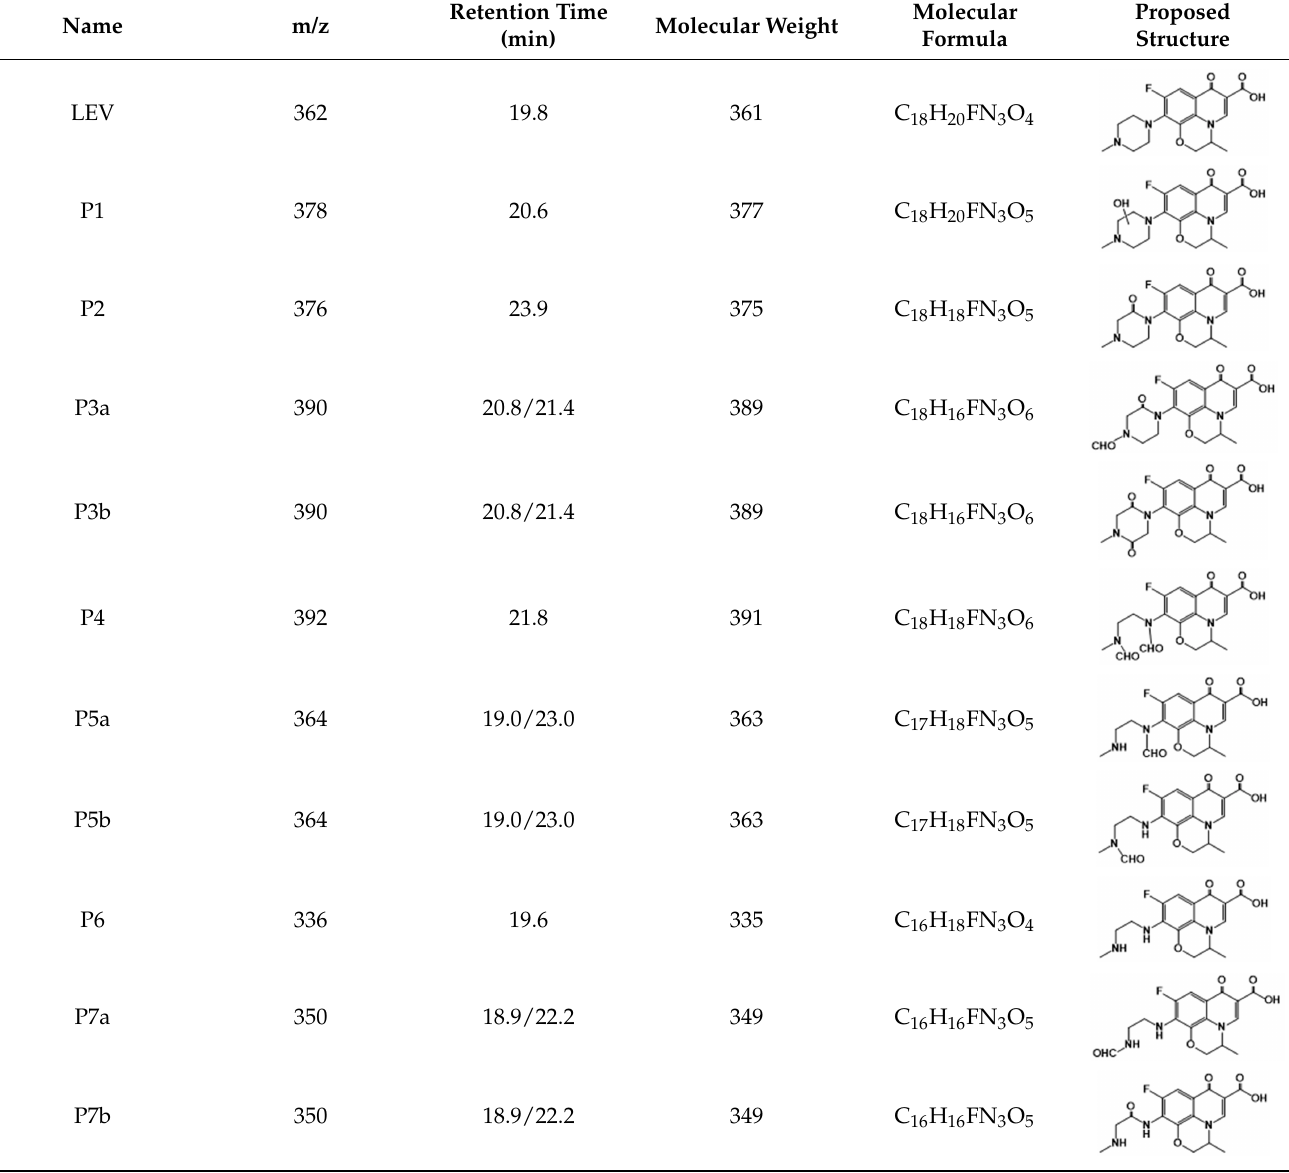
Table 2. Proposed byproducts in the process of photocatalytic removal of LEV.